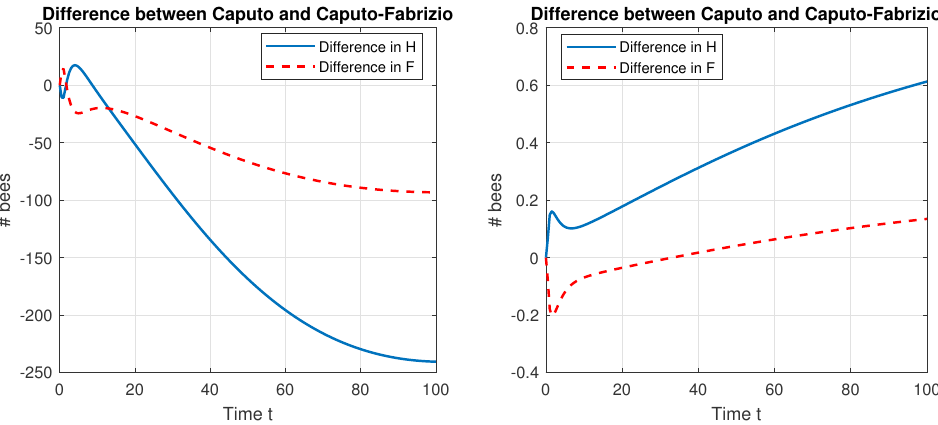
Figure 6. Differences between Caputo and Caputo–Fabrizio models with r = q = 0.95 ( left ) r = 0.9 and q = 0.95 ( right ).